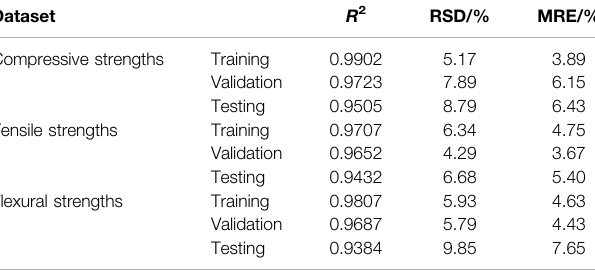
TABLE 10 | Results of performance criteria of the ELM model.